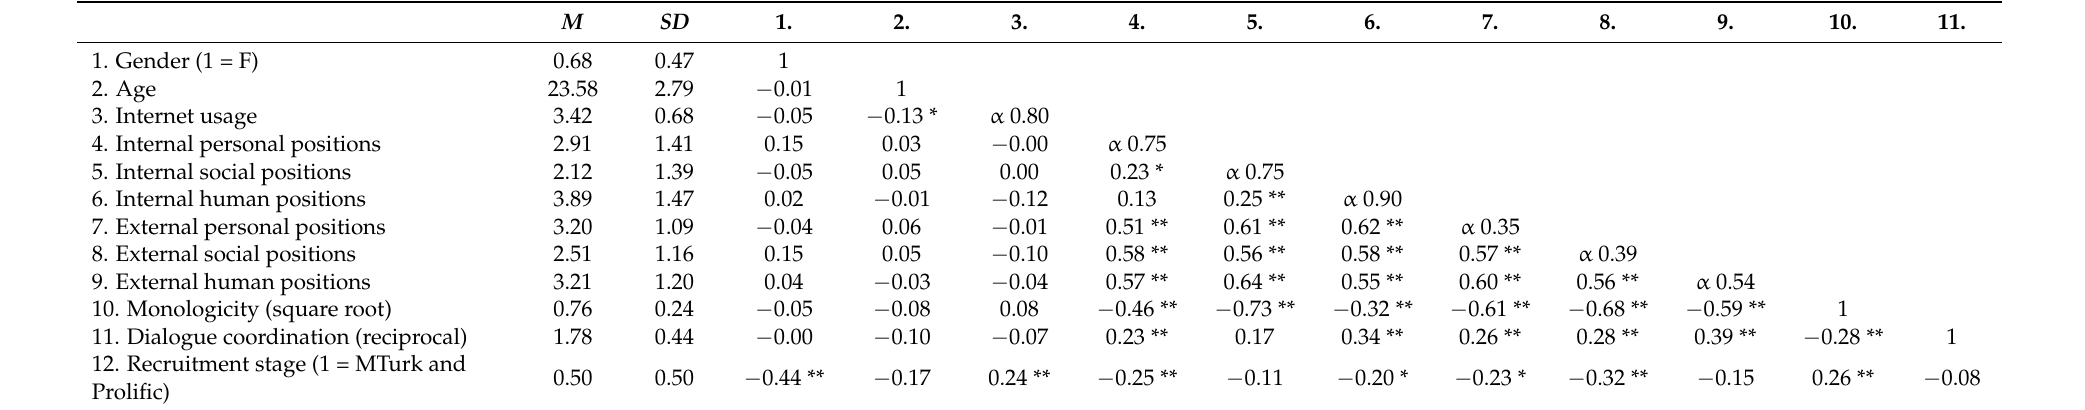
Table 1. Descriptive statistics and Pearson’s correlations among pre-dialogue variables ( n =